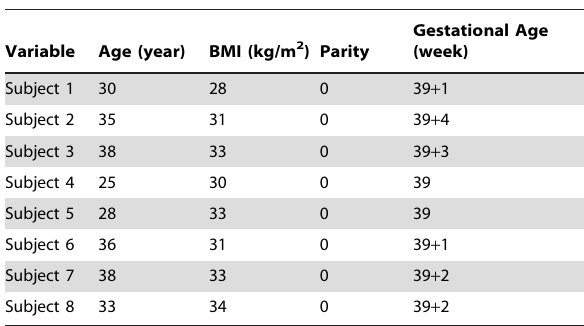
Table 2. Clinical characteristics of the women whose placentas were used for the explant studies. Subjects 1 to 4: Controls. Subjects 5 to 8: